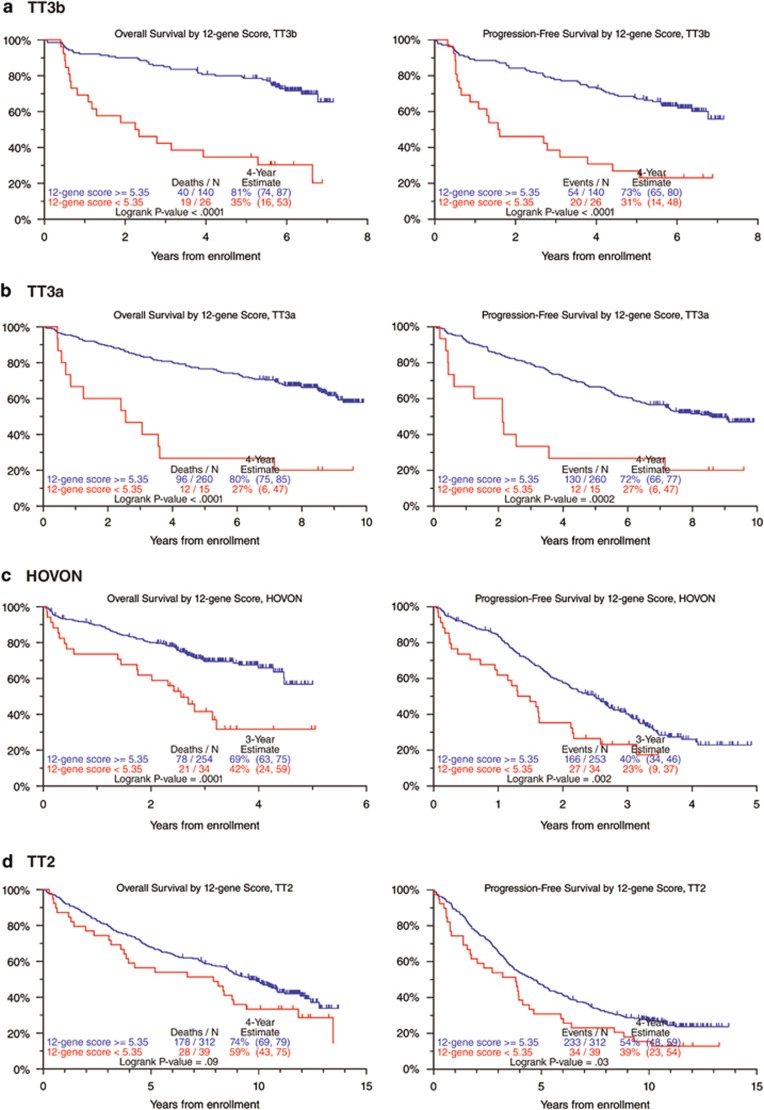
Kaplan–Meier plots of OS and PFS in TT3b (a), TT3a (b), ComBat-transformed HOVON (c) and TT2 (d), according to the 12-probeset score for genes associated with CIg.